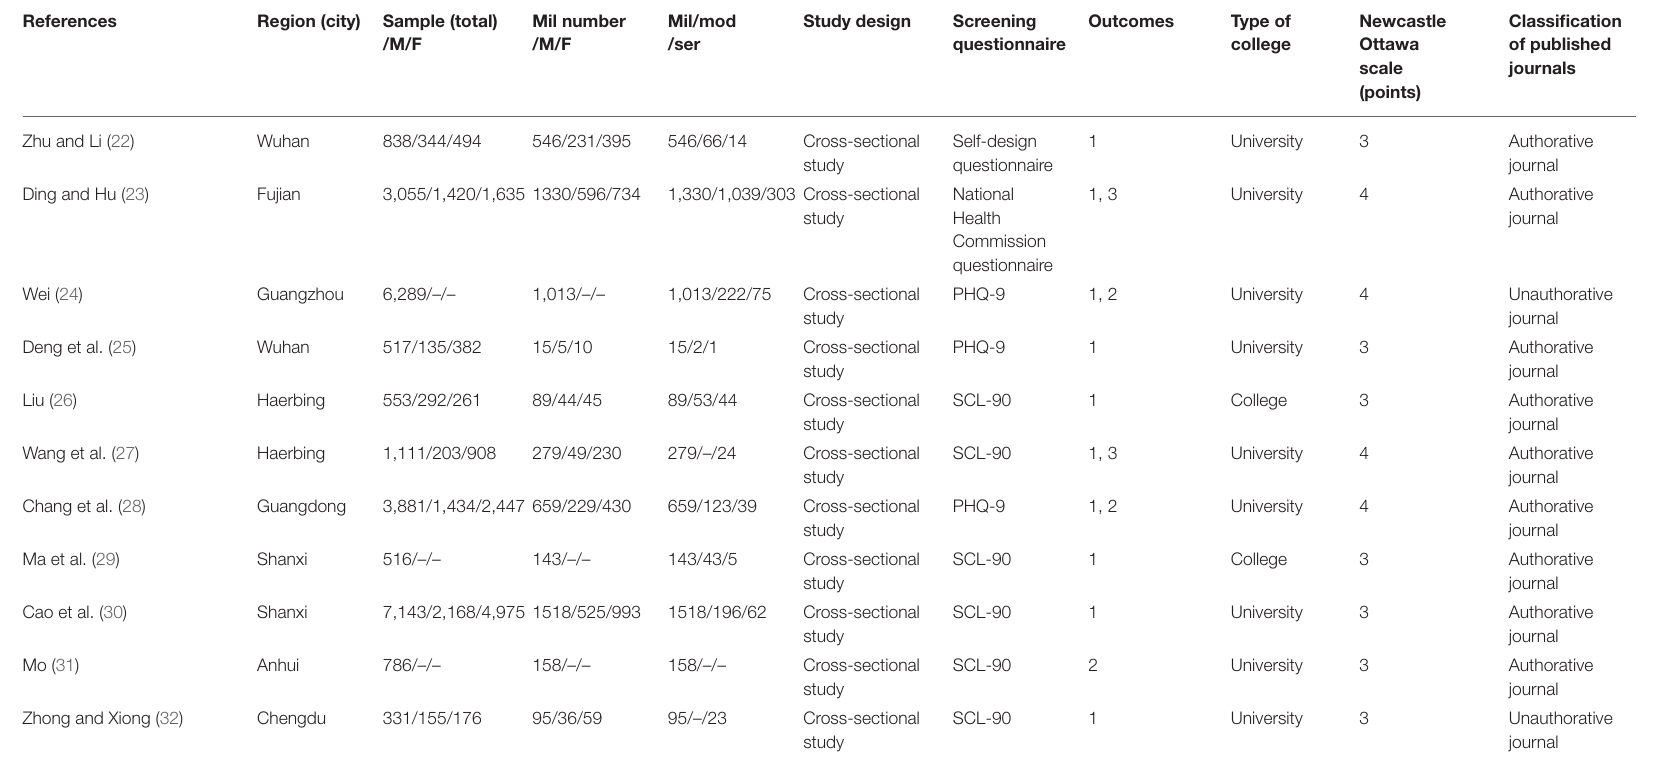
TABLE 1 | Basic information and data of all the included studies in the